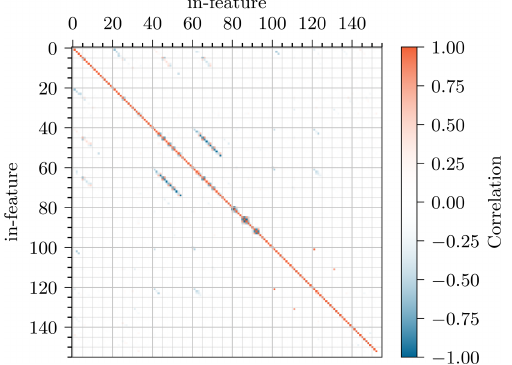
Figure 19. Cross-correlation of all input features based on mean posterior prediction of the 5000 test